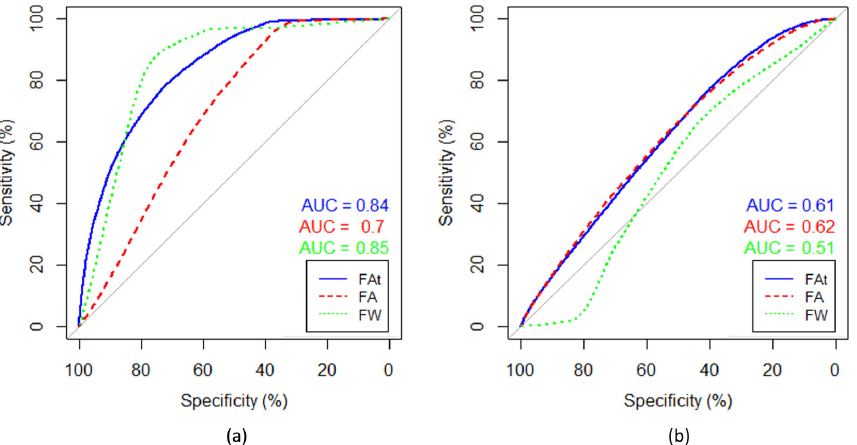
Figure 4. Receiver operator characteristics (ROCs) based on voxel-wise labelling. ( a ) ROC curves separating necrotic and enhancing tumor regions, and ( b ) ROC curves separating enhancing and non-enhancing tumor regions. Enhancing tumor region is defined as the true positive and the adjacent necrotic tumor region as the true negative. The patient is the same as the one shown in all single patient examples in this paper. The data were fitted to a logistic regression model and the ROC was computed for free-water (FW)-corrected fractional anisotropy ( FA ) (blue), non-corrected FA (red), and FW (green). Area under curve (AUC) is rendered in corresponding colors.